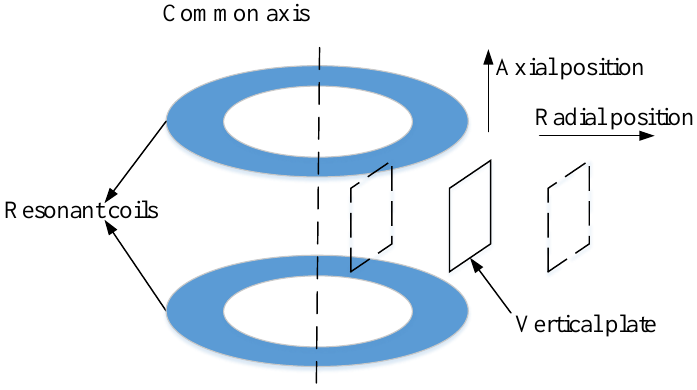
Figure 4. The arrangement of the vertical plate simulation.